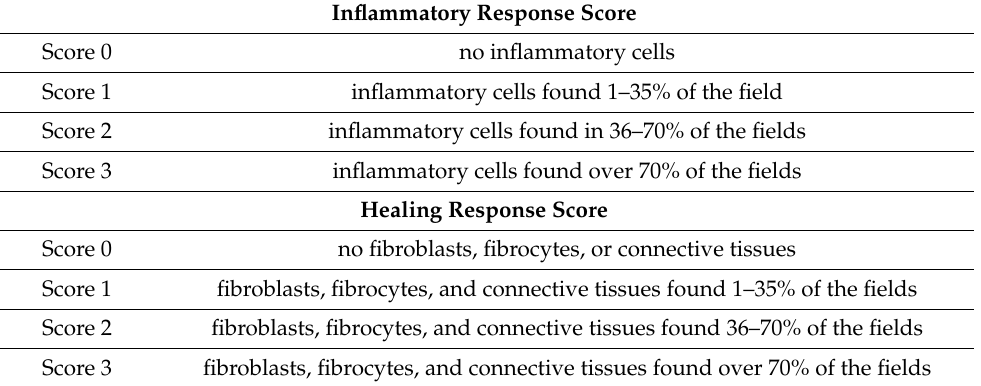
Table 2. Histopathological